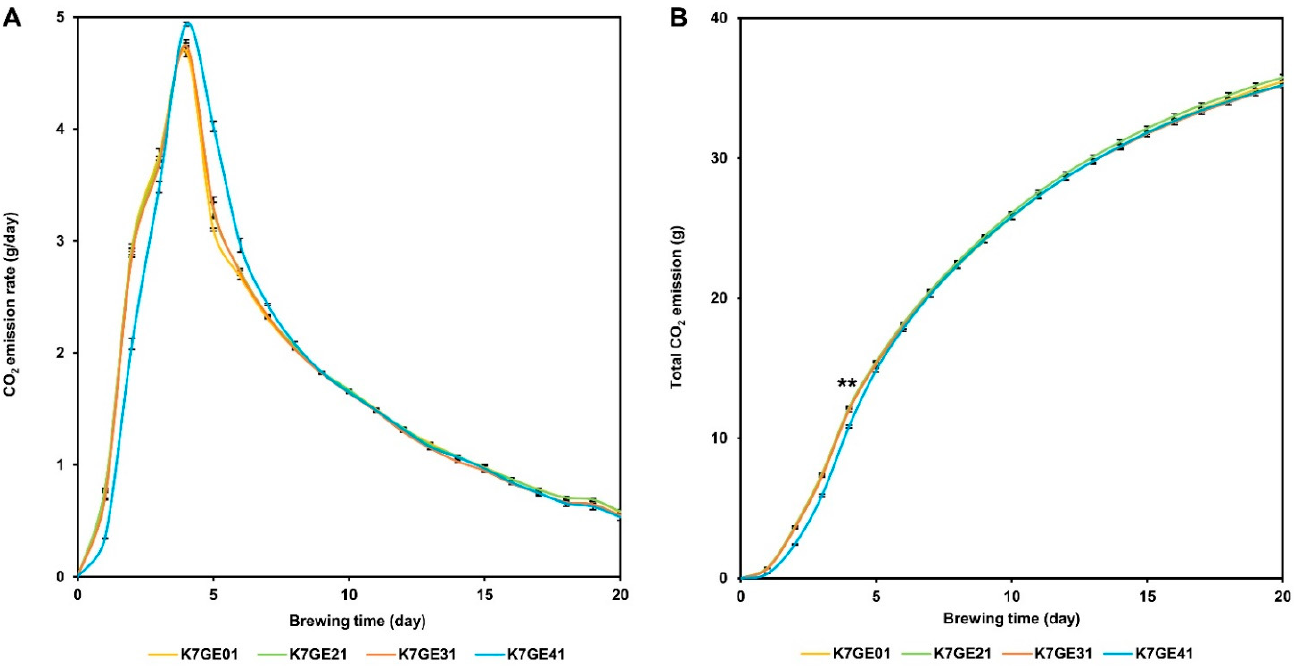
Figure 4. Carbon dioxide (CO 2 ) emissions of genome-edited sake strains. Daily ( A ) and total ( B ) CO 2 emissions measured by weight. K7GE01 (yellow), K7GE21 (green), K7GE31 (orange), and K7GE41 (blue) were examined. Error bars indicate standard error ( n = 3).** indicates a peak of CO 2 emission rate (day 4).